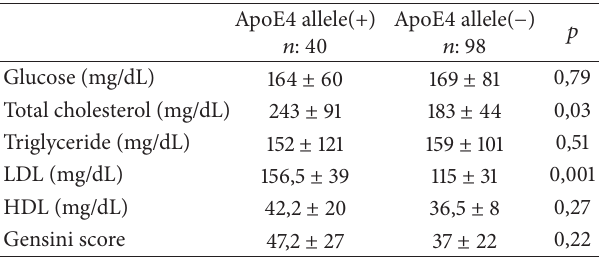
Table 2: Lipid and glucose levels in the patients with or without ApoE4 allele